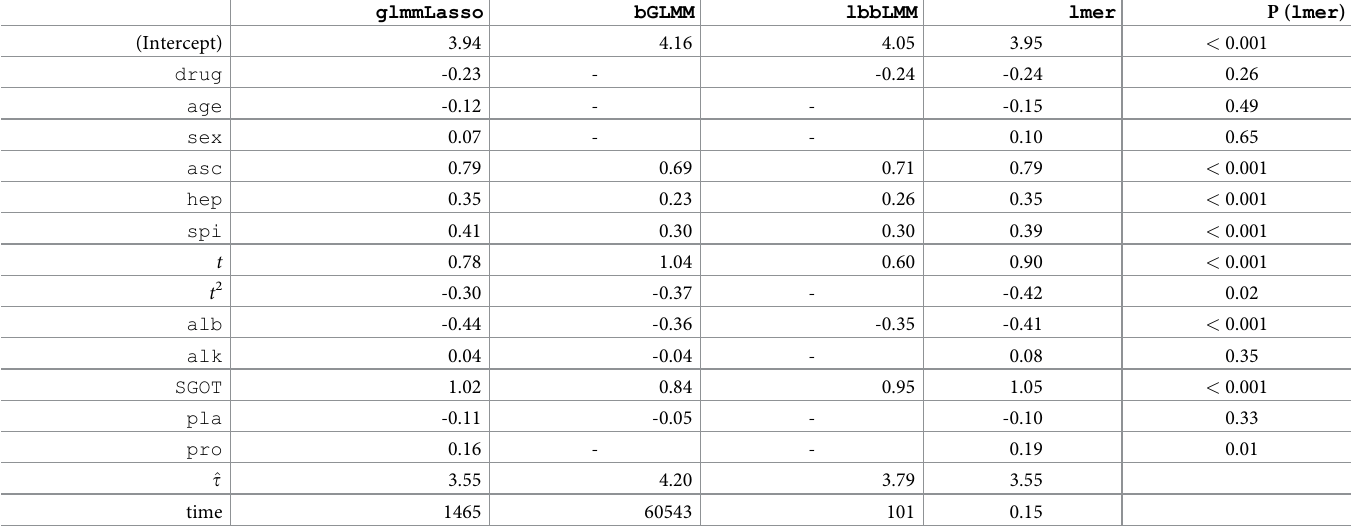
Table 10. Variable selection and shrinkage of various regularization approaches compared to lmer .